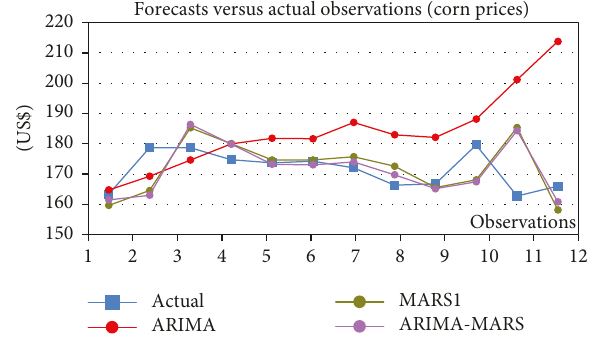
Figure 14: Forecasts of corn prices versus actual observations for the 12 testing records (with the use of ARIMA, MARS proposed ARIMA-MARS , and the 1